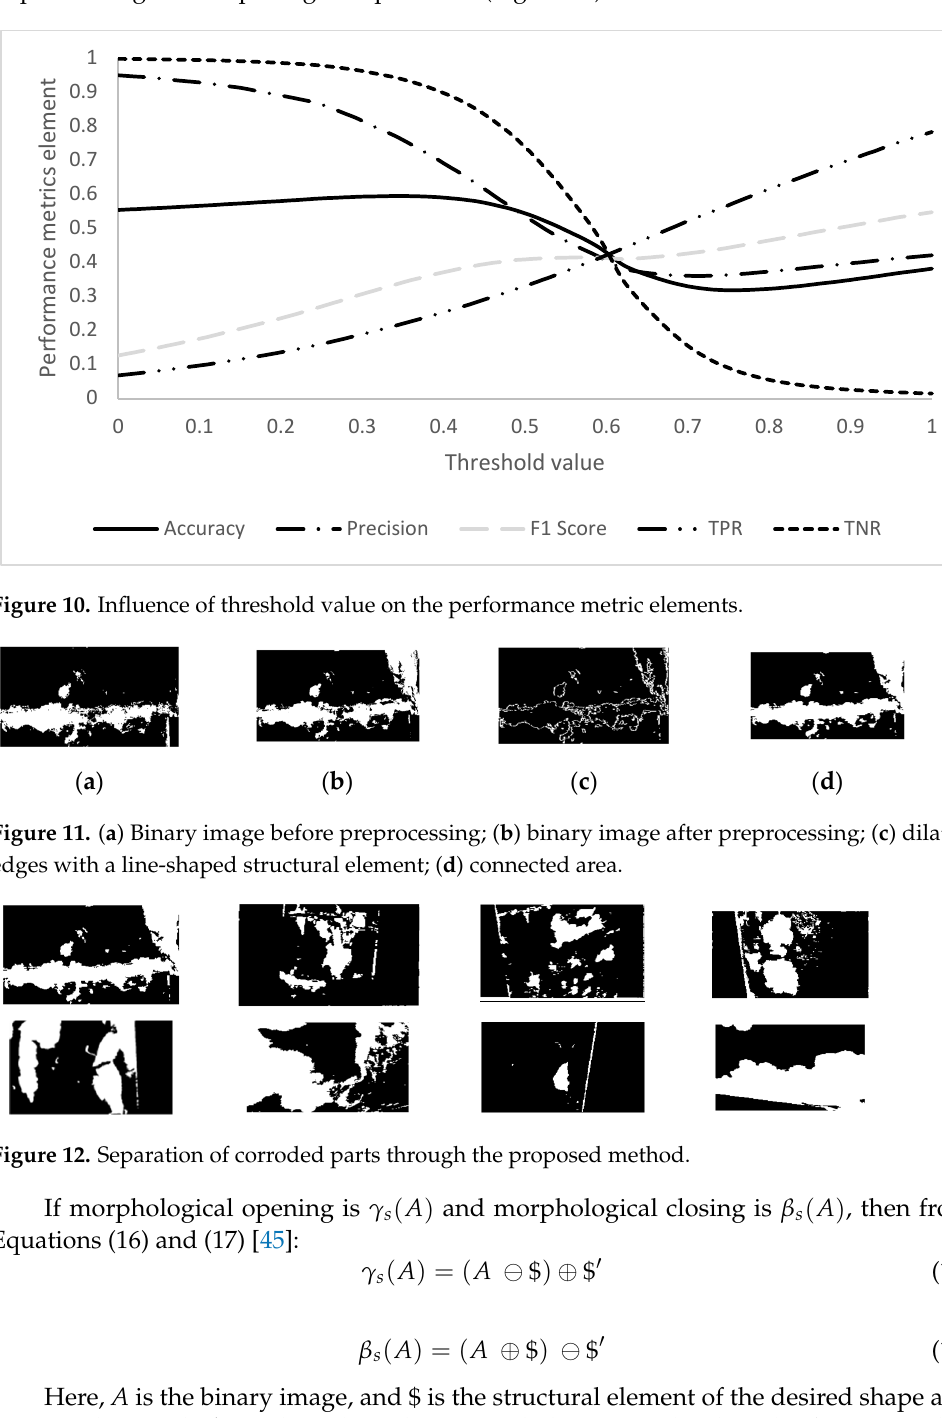
Figure 11. ( a ) Binary image before preprocessing; ( b ) binary image after preprocessing; ( c ) dilated edges with a line-shaped structural element; ( d ) connected area.